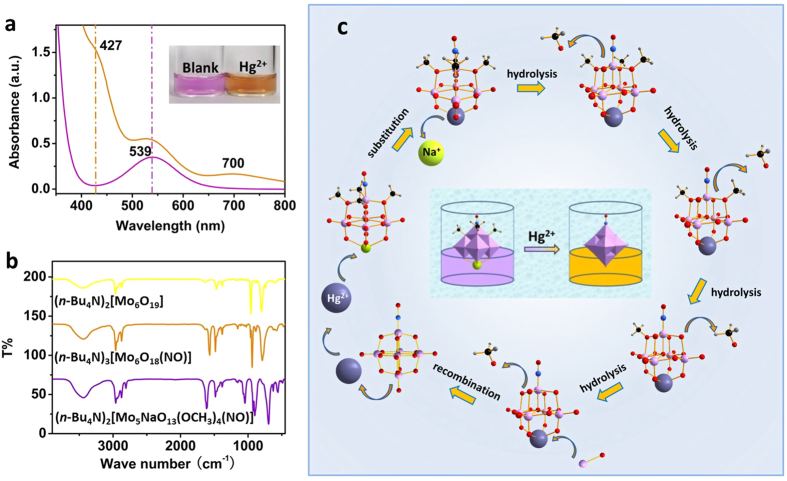
Colorimetric determination of Hg(II) by MLPOM.(a) UV-vis spectra of MLPOM (50 μM) in the absence (purple) and presence (brown) of Hg2+ ions (10 μM). Inset: photographs of MLPOM (50 μM) in the absence (purple) and presence (brown) of Hg2+ ions (10 μM). (b) IR spectra of (n-NBu4)2[Mo5NaO13(OCH3)4(NO)] (purple), (n-Bu4N)3[Mo6O18(NO)] (brown) and (n-Bu4N)2[Mo6O19] (yellow). (c) Schematic diagram of the probable structural transformation procedure from [Mo5NaO13(OCH3)4(NO)]2− to [Mo6O18(NO)]3− in the presence of Hg2+. Ball-and-stick representation of [Mo5NaO13(OCH3)4(NO)]2−, [Mo6O18(NO)]3− and their possible intermediates: Mo, light purple; Na, lime; O, red; N, blue; C, black; H, light gray; Hg, blue gray.